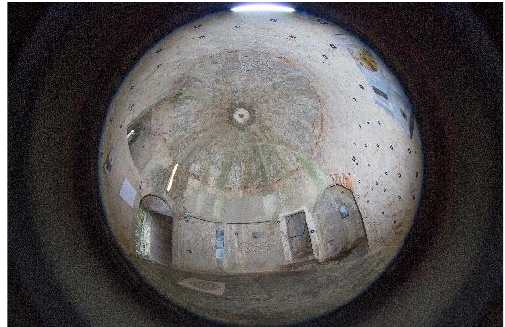
Figure 5: Front capture of the runner at the Castle.